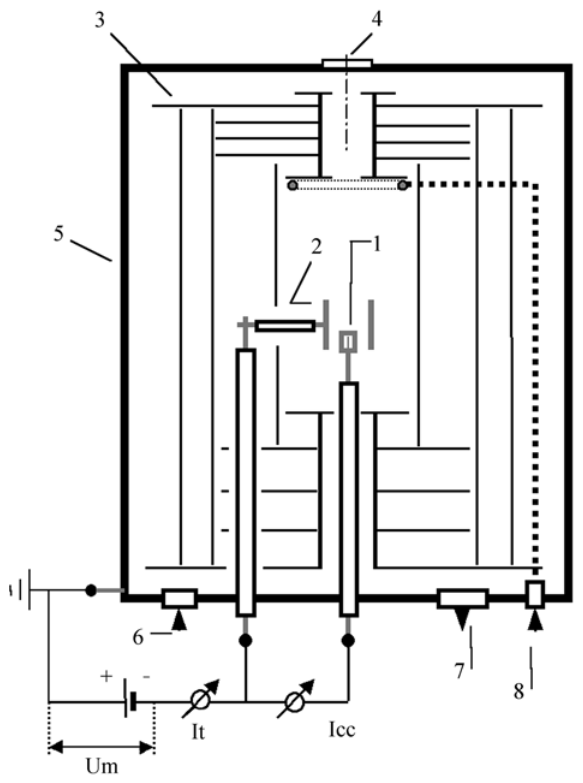
Figure 1. Simplified representation of the discharge